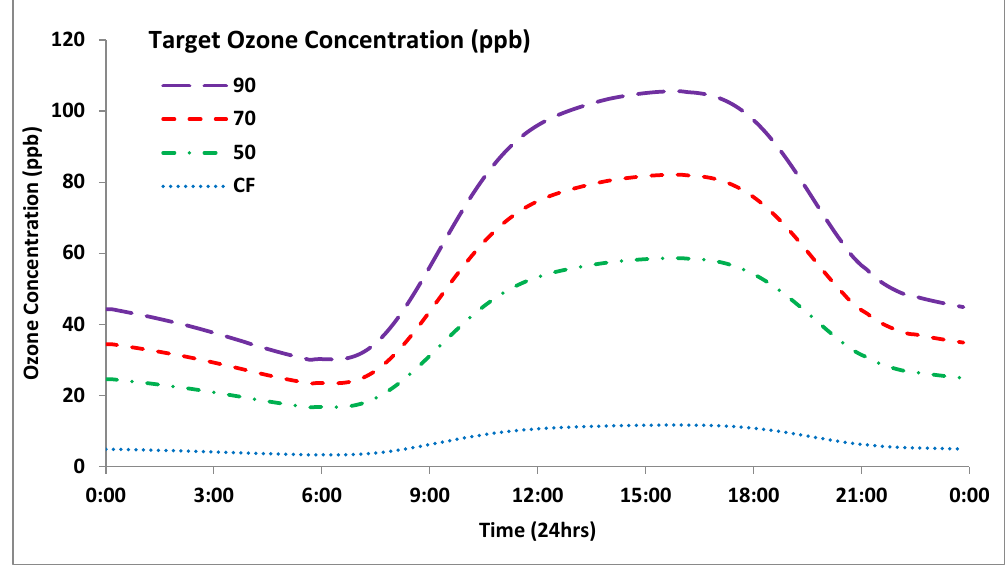
Figure 2. Smooth predefined diurnal profiles targeted as O 3 exposure regime in outdoor plant environment chambers (OPECs). The actual achieved treatments were 5, 46, 65, and 84 ppb, respectively.